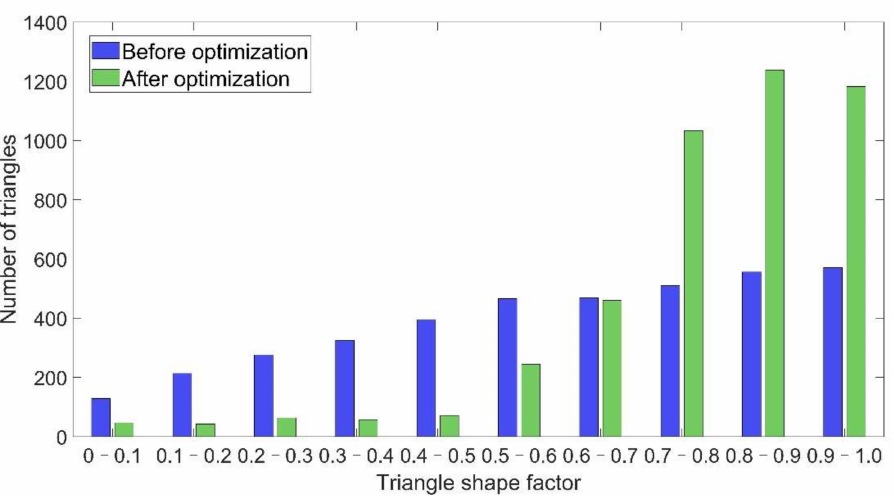
Figure 13. Comparison of triangle shape factor distribution before and after global ocean unstructured grid optimization.